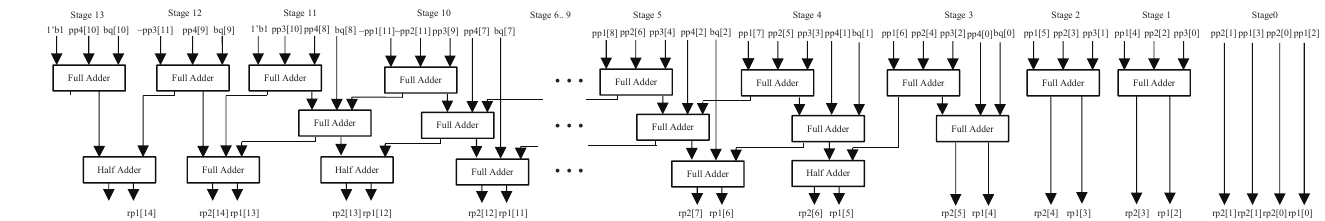
Figure 14. Compressor circuit used in the multifunction implementation with reuse of computing units. The symbols rp1 and rp2 are the two results of the